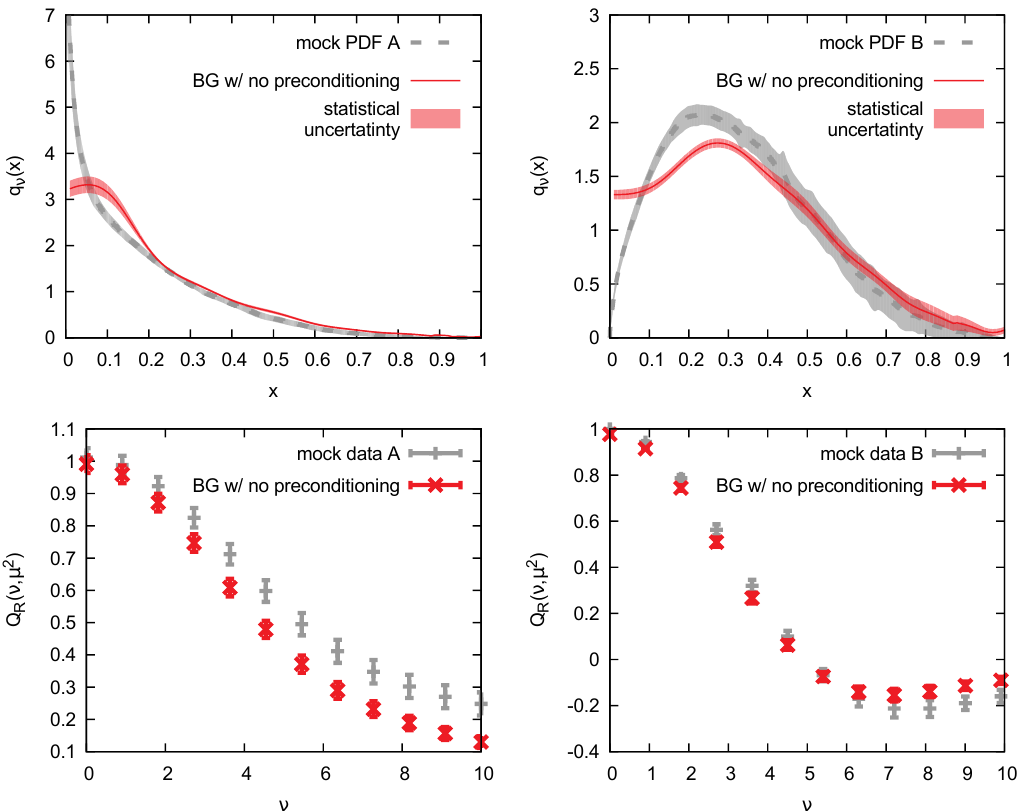
Figure 5 . x -space PDF’s reconstructed using the Backus-Gilbert (BG) method from N (cid:23) = 12 Io(cid:11)e-time data points on the interval (cid:23) = [0 ; 10] (top) as well as the input data (gray crosses) compared to the data arising from the reconstructed PDF (red crosses) in the bottom panels. The plots in the left column show the results for mock data based on a phenomenological PDF, while the right column from the modi(cid:12)ed scenario where the PDF vanishes at the origin. In both scenarios no preconditioning has been